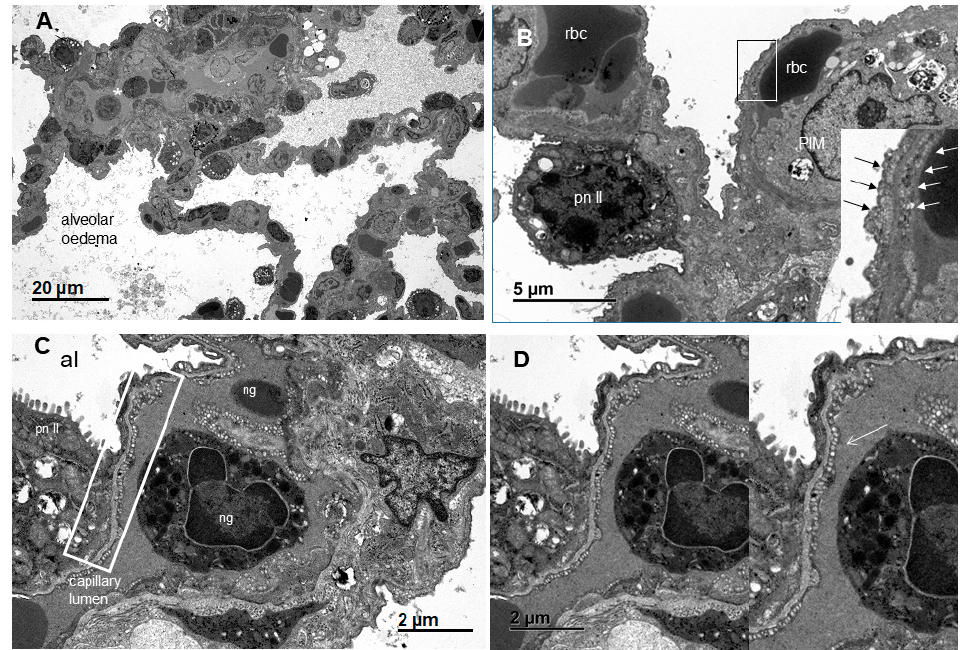
Figure 9. ( A , B ) TEM of normal pig lung. Normal pig lung represents the lung tissue that was taken during the pneumonectomy of the recipient left lung. Pulmonary intravascular macrophages and intracapillary RBCs are present, the pneumocyte coverage appears adequate. There is no evidence of degenerative or other, i.e., inflammatory changes. Endothelial cells and to a lesser extent type I pneumocytes exhibit pinocytic vesicles. This sample is an example of normal structure with unaltered cells in the pig lung. There is evidence of gas exchange (more on the endothelial side). ( A ) Mildly dilated capillary with single rbc, and ( B ) close-up view of the white rectangle in ( A ) showing the endothelial pinocytic vesicles (arrows). Pn I: Pneumocyte type I, pn II: Pneumocyte type II, bm: basal membrane, rbc. Red blood cell, en: endothelial. Cells 2020 , 9 , x FOR PEER REVIEW